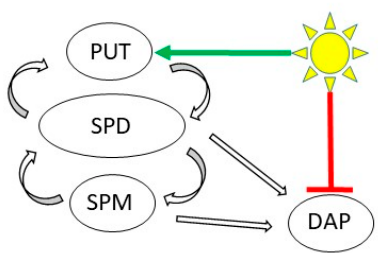
Figure 13. Schematic representation of the effects of light on polyamine pool. Light induces the pu- trescine (PUT) level first and it also reduces the 1,3-diaminopropane (DAP) content. (SPD: spermidine, SPM: spermine).